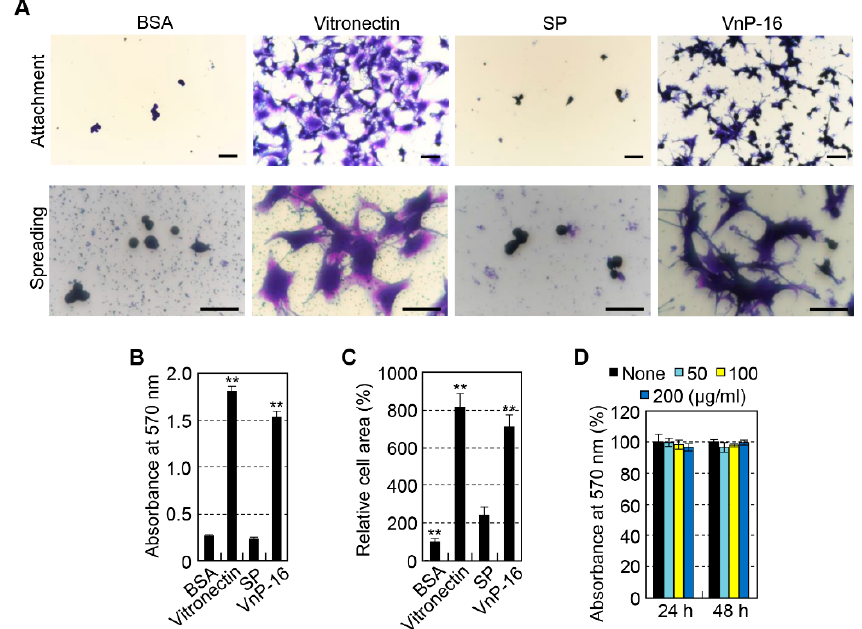
Figure 3. Cell attachment and spreading of osteoblast-like MG-63 cells seeded on culture plates treated with vitronectin and synthetic peptides. ( A ) Photographs of osteoblast-like MG-63 cells adhering (upper panel) and spreading (lower panel) to culture plates treated with 1% bovine serum albumin (BSA), vitronectin (0.26 µ g / cm 2 ), scrambled peptide (SP), and VnP-16 peptide (10.5 µ g / cm 2 ). Bar = 100 µ m. ( B – C ) Cell attachment ( B ) and spreading ( C ) to immobilized synthetic peptides. MG-63 cells were allowed to adhere to peptide-treated plates for 1 h ( B ) or 3 h ( C ) in serum-free medium. ( D ) The viabilities of osteoblast-like MG-63 cells treated with VnP-16 for 24 or 48 h. ** p < 0.01 vs. the SP-treated control group. Data in ( B – D ) ( n = 4) represent the mean ± SD.